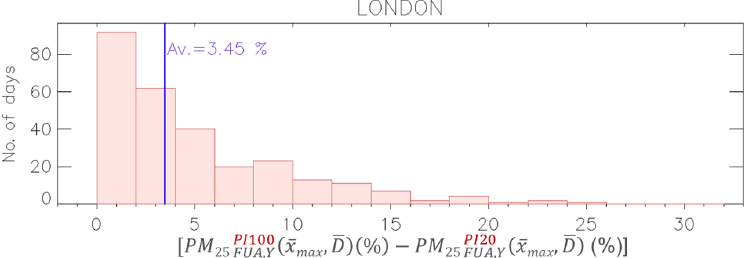
Figure 3. Histogram of daily city contribution differences to London PM 2 . 5 levels between two potential impacts methods, PI100 and PI20, calculated with the EMEP model. The source is defined spatially as the FUA where emissions are reduced yearly ( Y subscript). The receptor is defined spatially as the city location where the maximum yearly averaged concentration is modelled ( x max ) and temporally as daily average ( D ). Each column represents the number of days with a specific PI difference (PI100 − PI20). The blue line provides the yearly average